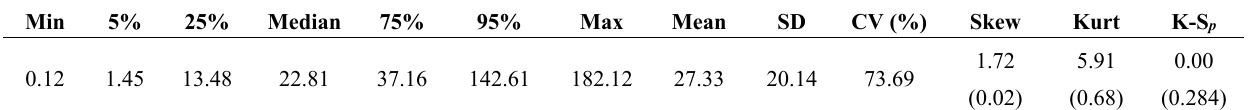
Table 1. Descriptive statistics of forest biomass carbon density (Mg ha − 1 , n = 839).